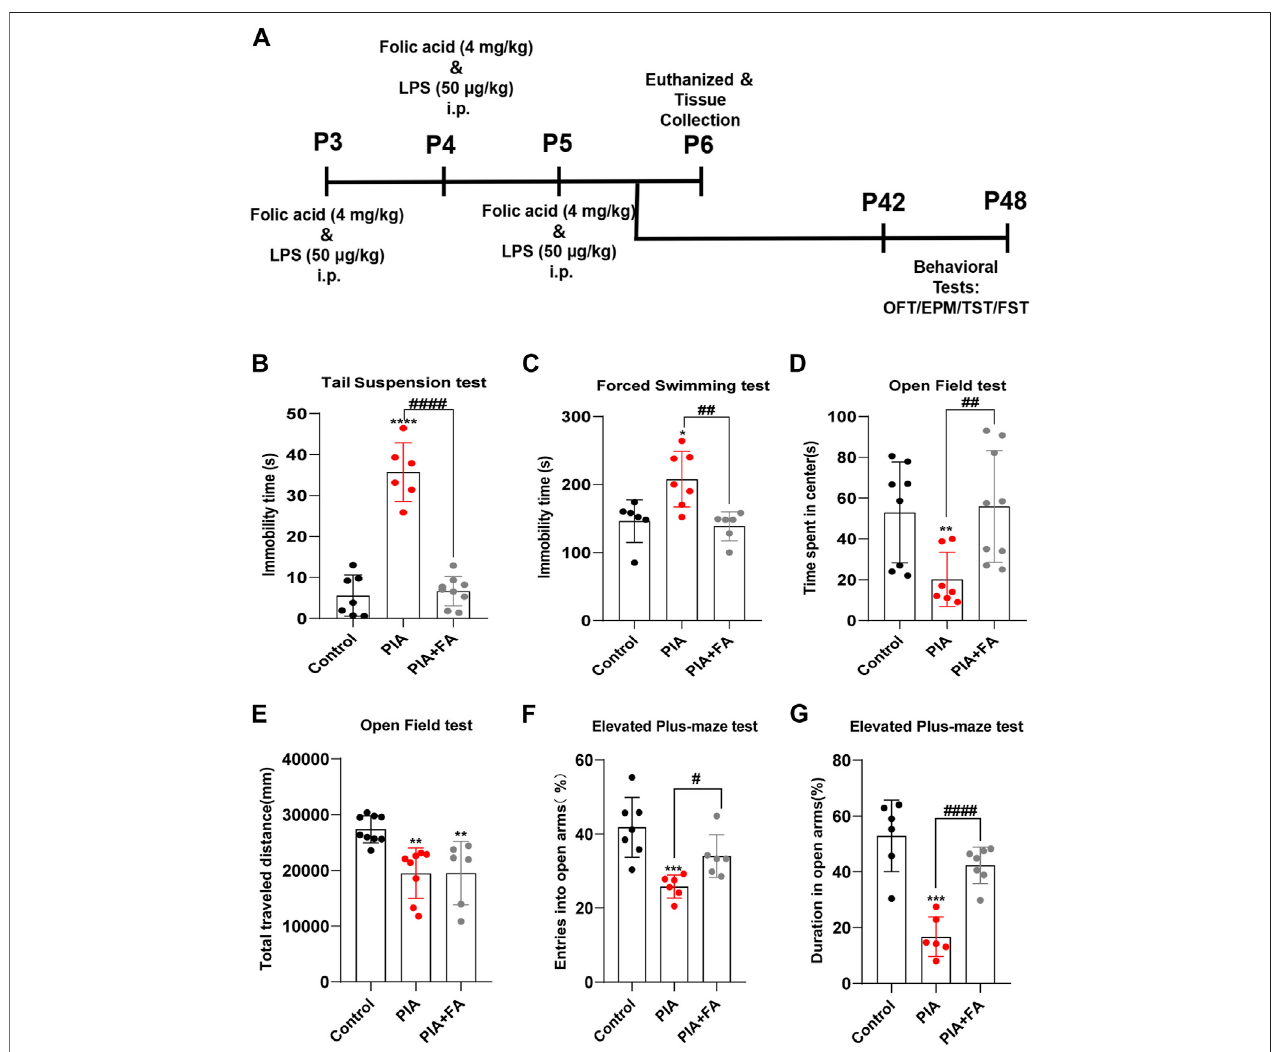
FIGURE 1 | FA improved PIA-induced depressive-like and anxiety-like behaviors in adults. (A) Schematic representation of the experimental design for the PIA model. (B,C) Immobilitytime inTSTand FST. FAimproved depressive-likebehaviorsinPIA-induced mice. (D) Timespent inthecenterofOFT. (E) Travelingdistances in OFTwere used toexamine motorability. (F) Thepercentageofentries intothe open arms inEPM. (G) The percentage oftime spent inthe open armin EPM. Anxiety-like behaviorswereevaluatedafterRAtreatmentinEPMandOFT.Data:mean±SEM;* p < 0.05,** p < 0.01,*** p < 0.001,**** p < 0.0001versusthecontrolgroup; # p < 0.05, ## p < 0.01, #### p < 0.0001 versus the PIA group; n = 6 – 9 per group (one-way